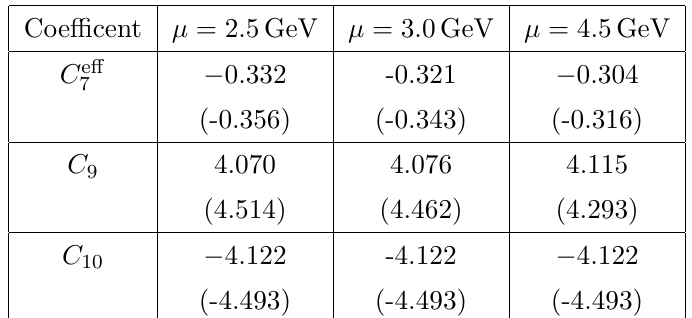
Table 3 . Wilson coe(cid:14)cients of the FCNC operators at next-to-leading (leading) order in (cid:11) s used in our numerical analysis at various scales.